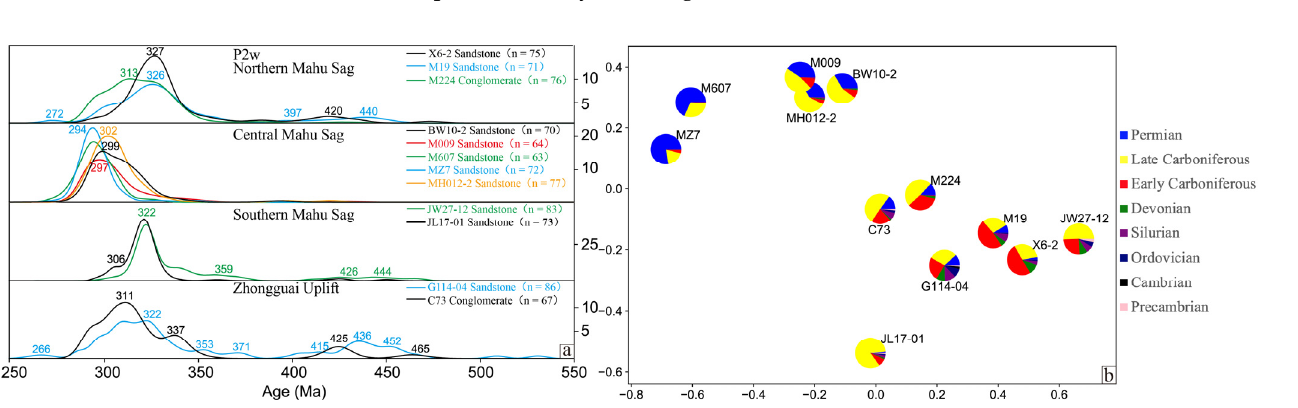
Figure 8. Spatial distribution of the zircon-tourmaline-rutile (ZTR) index of the Lower Wuerhe For- mation in the Mahu-Zhongguai area.